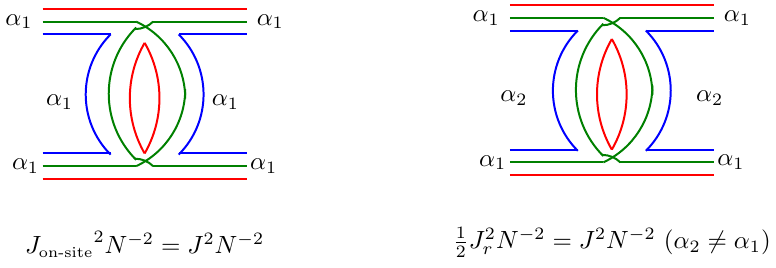
Figure 6. Contribution of interactions to dipoles of red color. For (cid:11) 1 = (cid:11) 3 6 = (cid:11) 2 = (cid:11) 4 , there are two con(cid:12)gurations that can give a contribution to the dipole of red color.